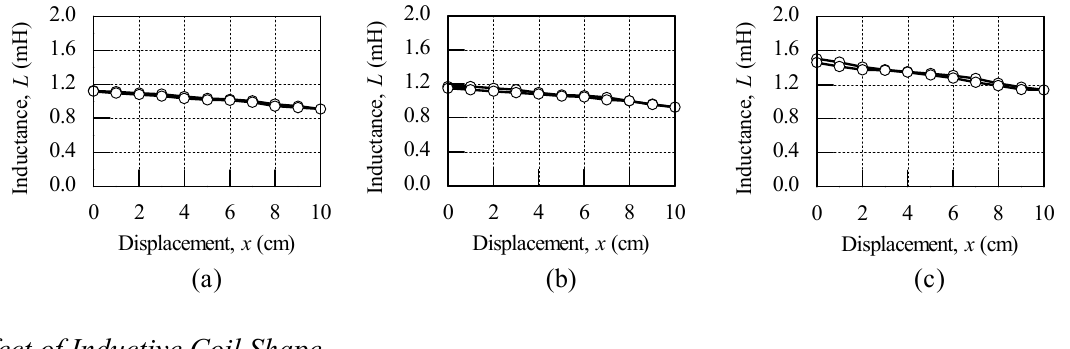
= 0.2 V (b) V =0.5 V (c) V = 1.0 V. in in in